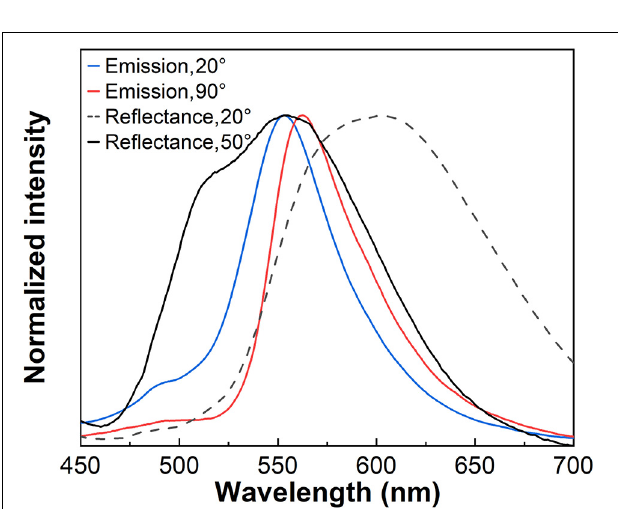
FIGURE 8 | Emission spectra of CS4-Rh at 20 ◦ and 90 ◦ detection angles under excitation at 348 nm. Reflectance spectra of the same sample at 20 ◦ and 50 ◦ detection